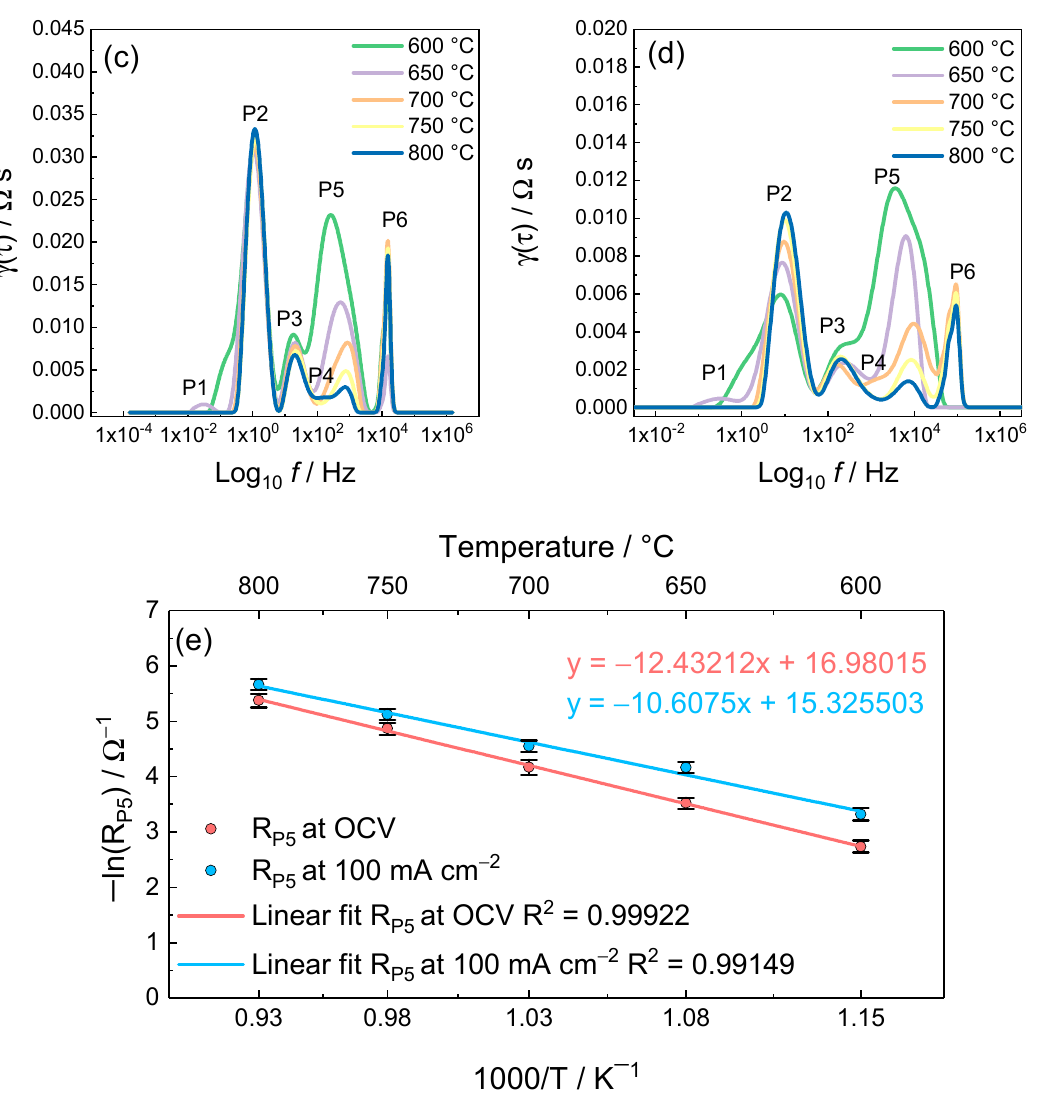
Figure 4. Nyquist plots obtained at different working temperatures at ( a ) OCV and ( b ) under a 100 mA cm − 2 load. DRT deconvolution at ( c ) OCV and ( d ) under 100 mA cm − 2 load. ( e ) Arrhenius plot of RP5 with linear fit at both OCV and under 100 mA cm − 2 load. FE = 50 mL min − 1 H 2 (xH 2 = 97%), AE = 50 mL min − 1 air (xO 2 = 21%).